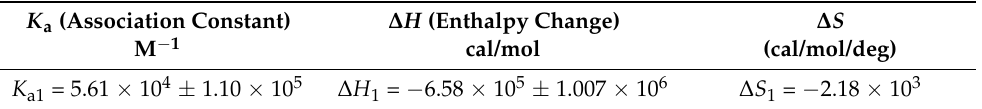
Table 8. Thermodynamic parameters obtained from ITC for Rv1636_ β -Amyrin system.